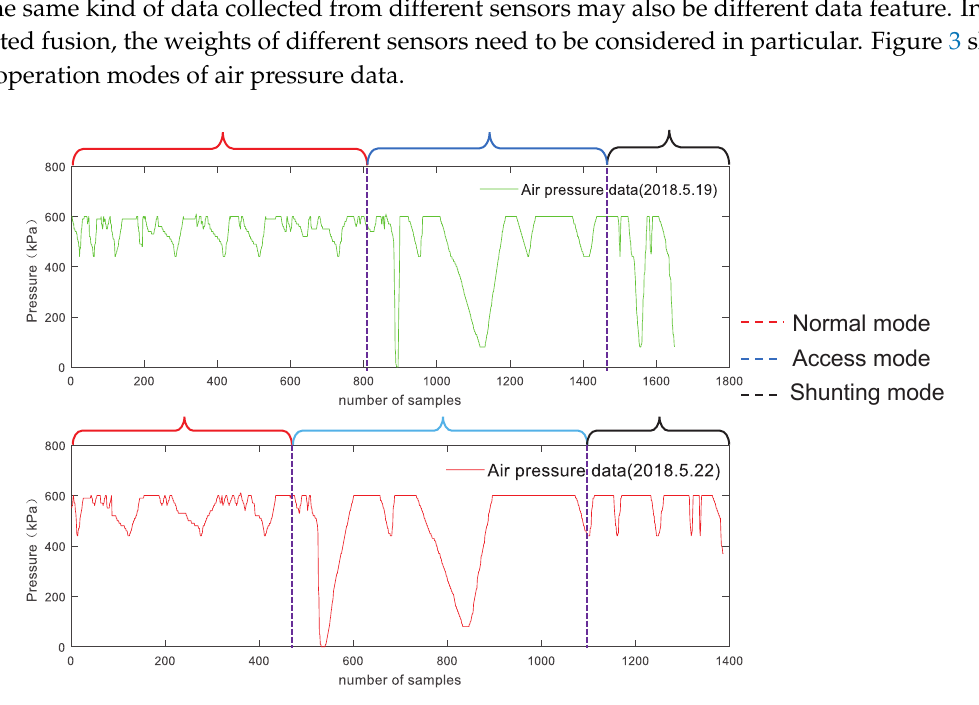
Figure 3. The architecture of the improved onboard safety computer